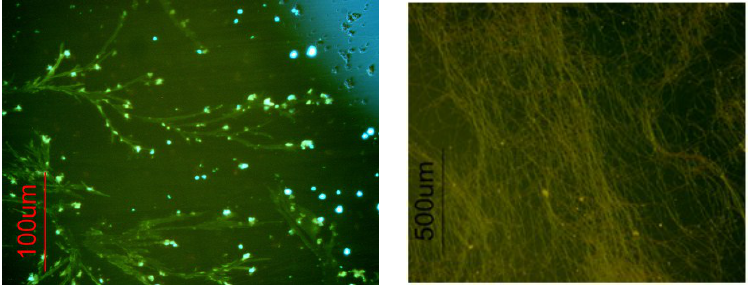
Figure 9. Fluorescence optical microscopy images of 12 ( left ) and 13 ( right ) with a 395–440 nm filter.